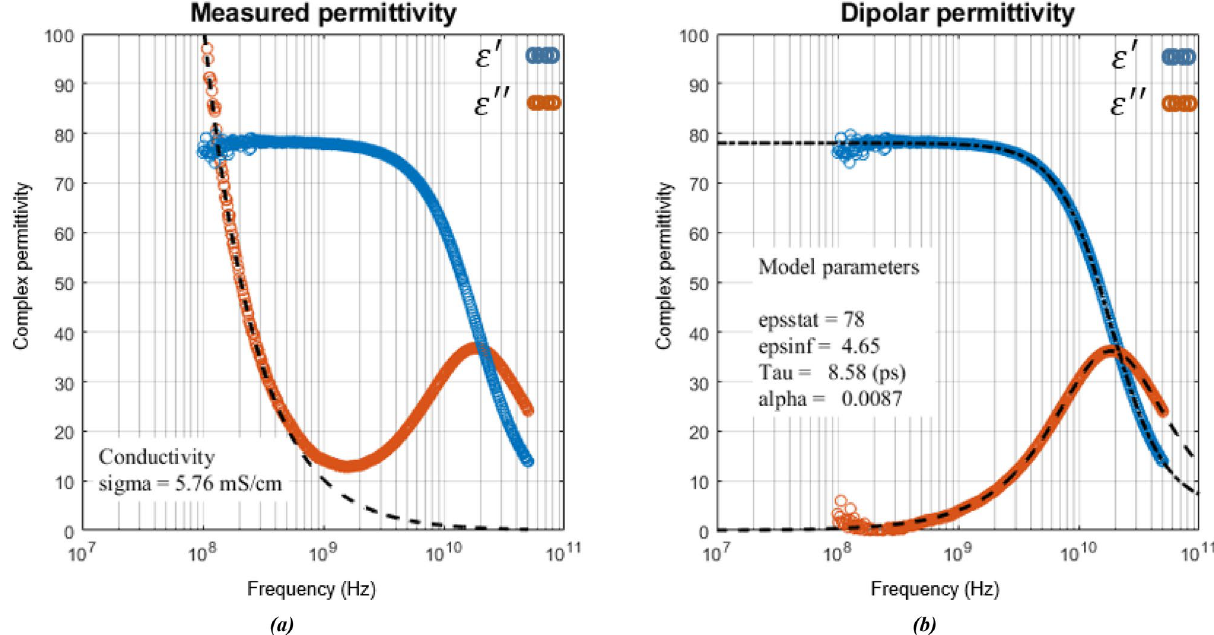
Figure 1. Complex permittivity of an aqueous solution: measured (o) and theoretical (–) values. ( a ) Determination of ionic conductivity using curve fitting of the imaginary permittivity in low frequency. ( b ) Determination of Cole–Cole parameters using fitting of the dipolar